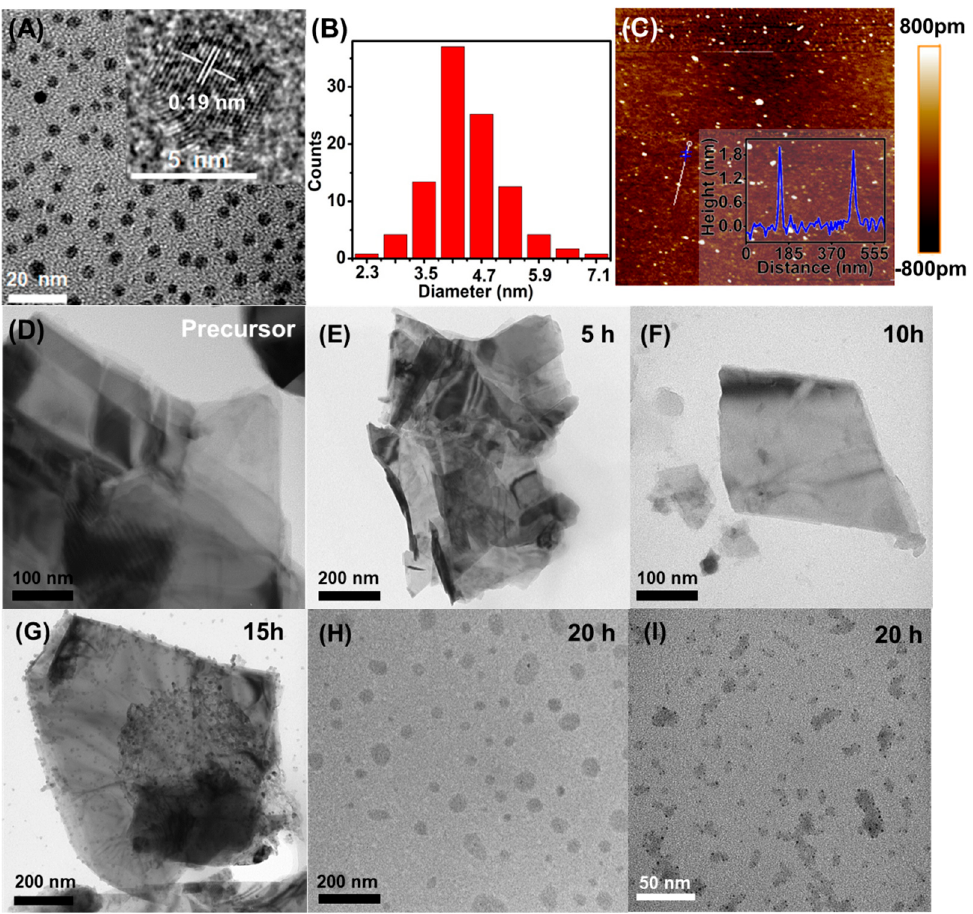
Figure 2. ( A ) TEM images (inset: HRTEM image), ( B ) particle size distribution, and ( C ) AFM image (inset: height profile) of the MoS 2 QDs. TEM images of the MoS 2 ( D ) precursor and ( E – I ) electrolysis precipitate upon different electrolysis time at 5, 10, 15, 20 h, respectively.